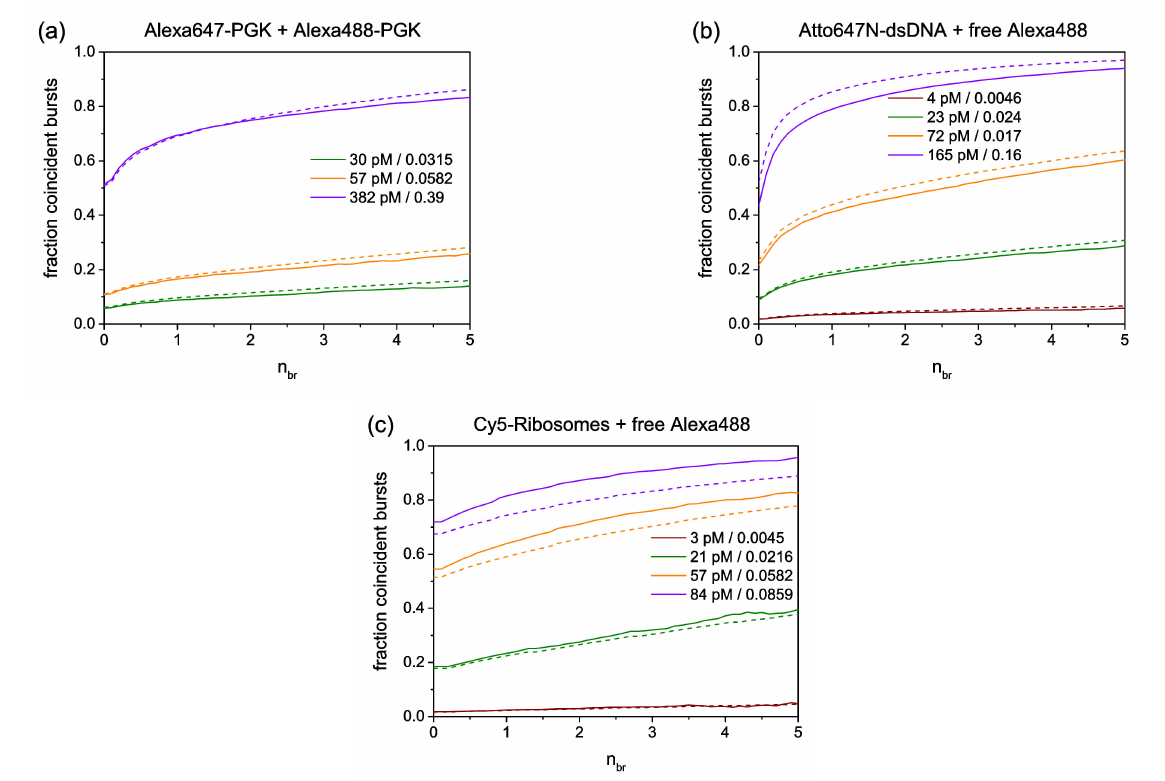
Figure 4. Measured (solid lines) and calculated (dashed lines) f RB values obtained from sam- ples with a pair of two distinct individually and freely diffusing molecules, one labelled red (Alexa647/Atto647N/Cy5) and the other labelled blue (Alexa488). The respective molecule con- centrations are given for the blue-labelled species (including the parameter N , the corresponding average number of molecules in the detection volume at the same time). The concentration of the red-labelled species (not given explicitly) was in the same regime as the blue-labelled species. The presented examples exhibited a clear variation in the relative sizes, and thereby in the corresponding burst duration times, τ d , of the respective molecules in the mixed samples: ( a ) similar size of red- and blue-labelled molecules, ( b ) larger red-labelled molecule versus smaller blue-labelled molecule (i.e., only Alexa488), and ( c ) very large red-labelled molecule versus small blue-labelled